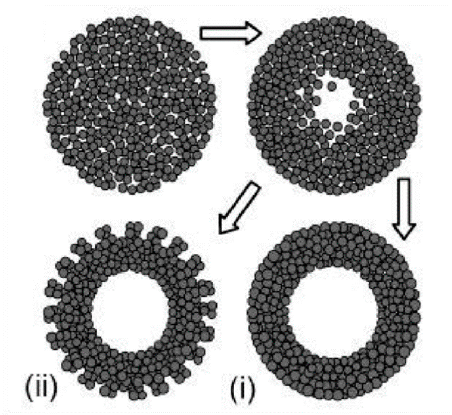
Figure 6. Two types of TiO 2 hollow structures via Oswald ripening by hydrothermal process. Type ( i ) shows a dense and smooth surface, while type ( ii ) displays a less compact surface due to the achieved crystallite extrusion. Reprinted with permission from [80]. Copyright 2004, American Chemical Society.